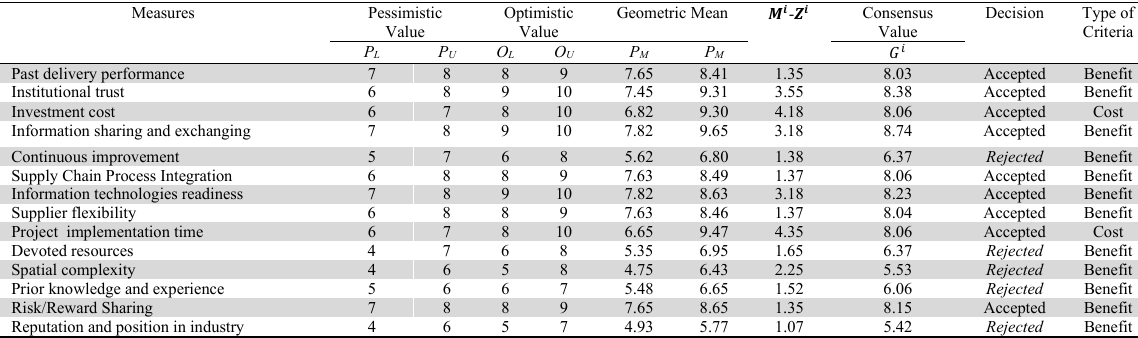
The result of Fuzzy Delphi method